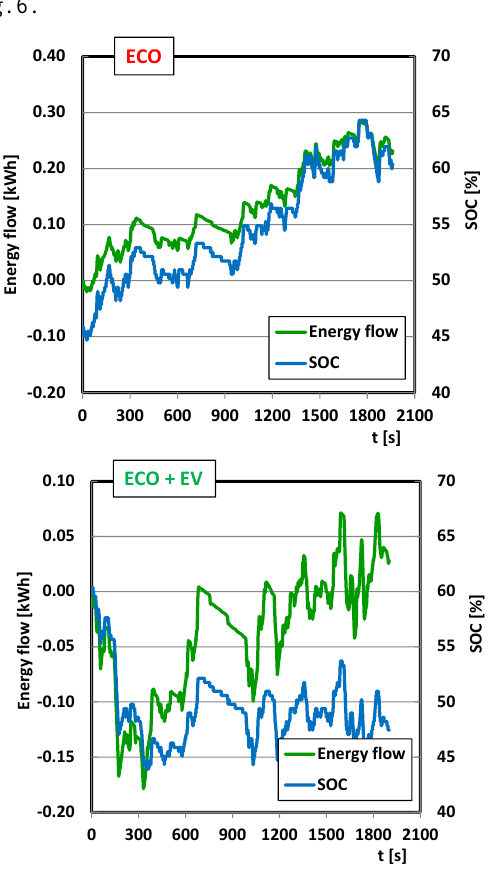
Fig. 4. Comparison of energy flow and changes in battery charge